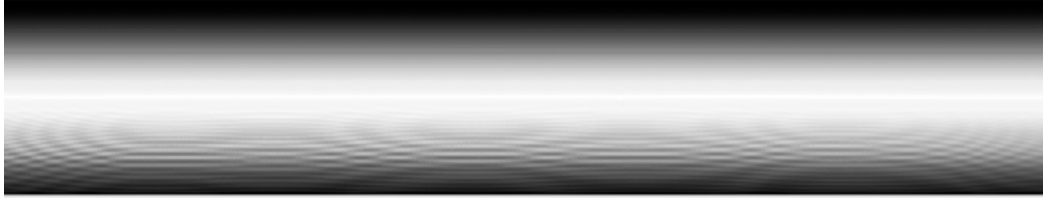
Figure 12. The correction result of calibration data using flat-field method.